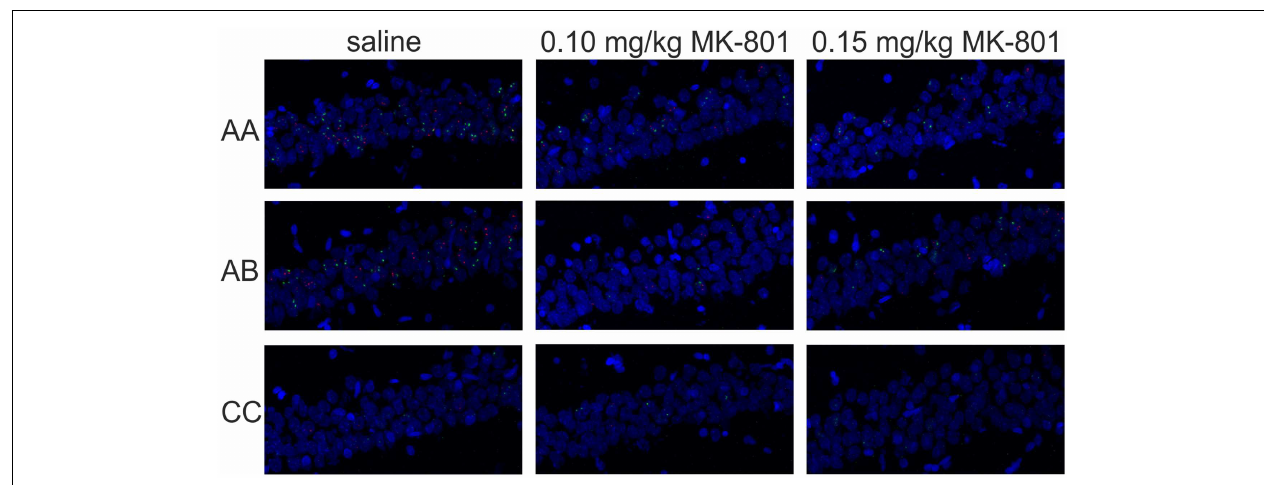
FIGURE 10 | Immediate-early gene expression in CA1 . Representative images showing expression of Homer 1a (green) and Arc/Arg3.1 (red) triggered in the CA1 region of the hippocampus by exploration of the same (AA) or two different environments (AB) after an injection of saline or MK-801 (0.10 and